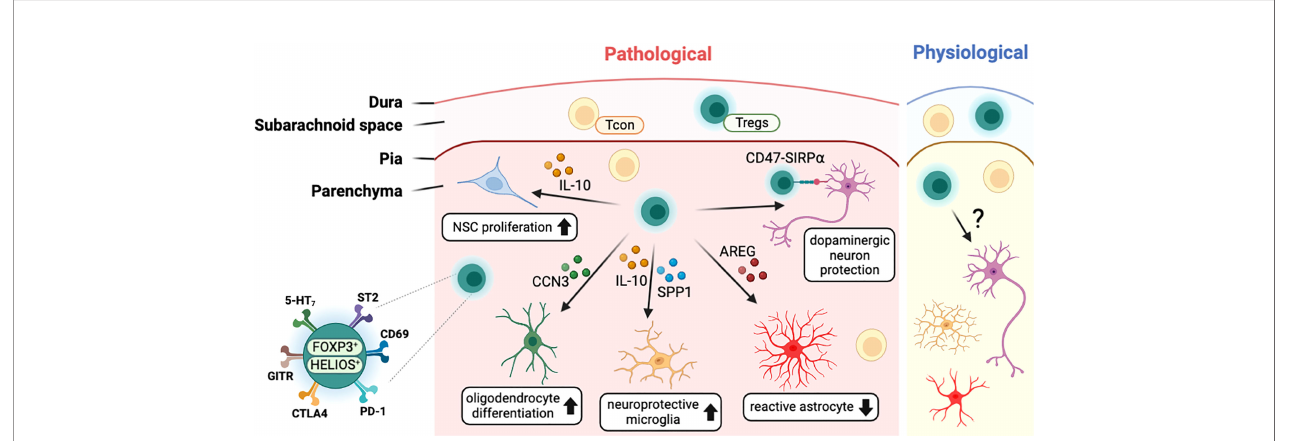
FIGURE 3 | Characteristics of CNS-resident Tregs and their interaction with other CNS cells. T cells including Tregs exist in the meningeal space and the brain parenchyma in both physiological and pathological conditions. In disease status, Tregs interact with CNS cells such as neural stem cells (NSCs), oligodendrocytes, microglia, astrocytes, and neurons to modulate the pathology of CNS insults. CNS-resident Tregs express a high level of Treg markers such PD-1 along with neuronal receptors including 5-HT7. CCN3, cellular communication network factor 3; SPP1, osteopontin; AREG, amphiregulin; SIRP a , signal regulatory protein alpha; 5-HT7, serotonin receptor 7; ST2, interleukin- 1 receptor-like 1; PD-1, programmed cell death 1; CTLA4, cytotoxic T-lymphocyte-associated protein 4; GITR, glucocorticoid-induced TNFR-related